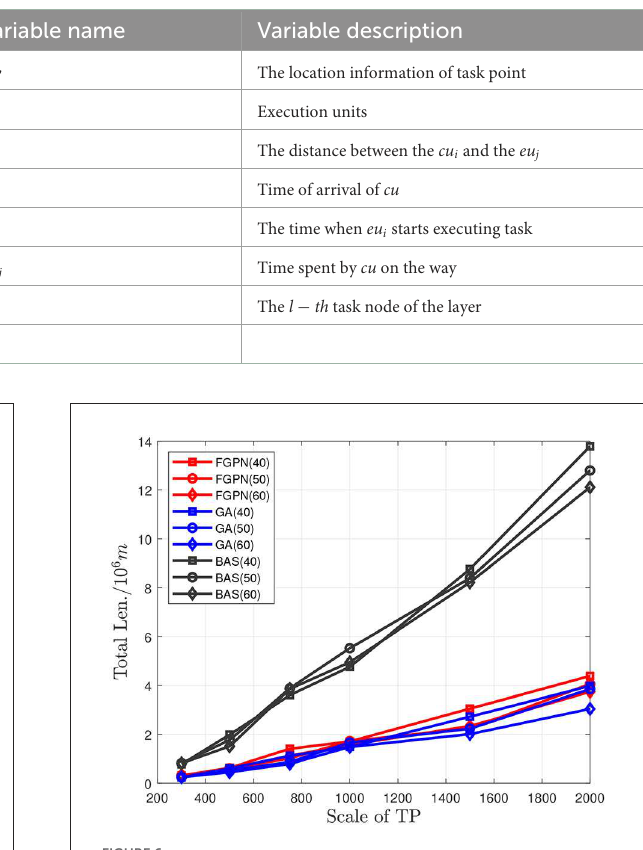
FIGURE6 Comparison between the total length of the three methods and the scale of task nodes when the number of target task nodes in the task cluster is 40/50/60.